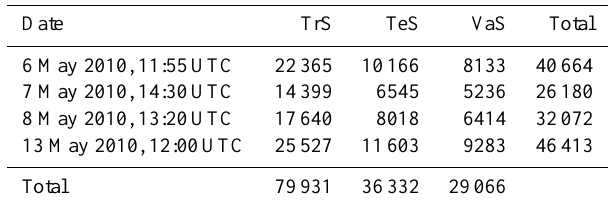
Table 1. MODIS TIR channels’ characteristics. Channel no.